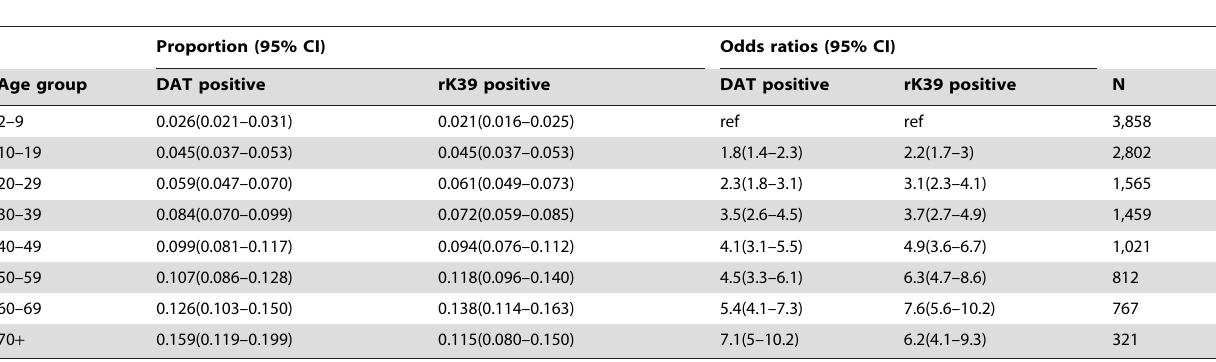
Table 1. Trends in DAT and rK39 serologic responses by age